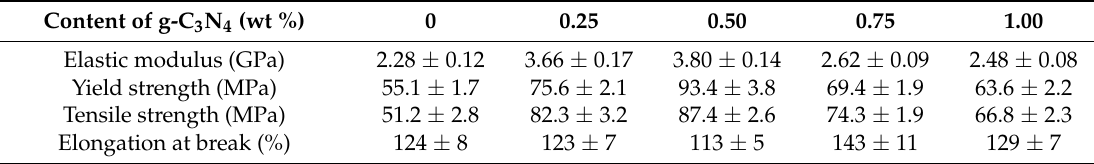
Table 1 . Mechanical performance of pure PVA and PVA/g-C 3 N 4 nanocomposites . Content of g-C 3 N 4 (wt %) Table 1. Mechanical performance of pure PVA and PVA/g-C 3 N 4 nanocomposites. Content of g-C 3 N 4 (wt